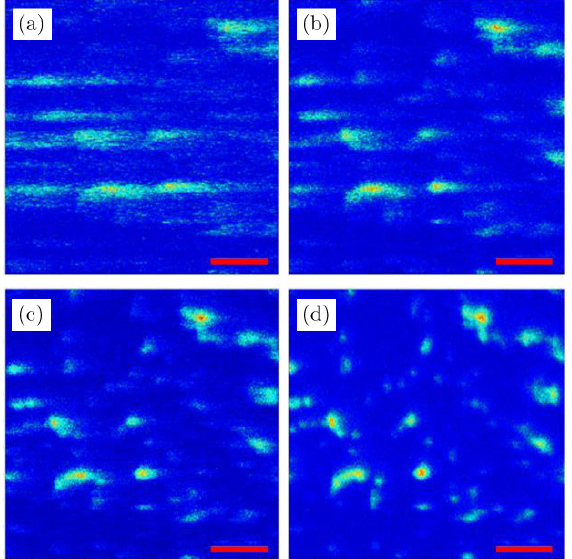
Fig. 2. Luminescent image of sparsely dispersed UCNPs at di®erent scanning speed: (a) 2 (cid:1) s per pixel, (b) 5 (cid:1) s per pixel, (c) 10 (cid:1) s per pixel, (d) 40 (cid:1) s per pixel. Scale bar represents 2 (cid:1)